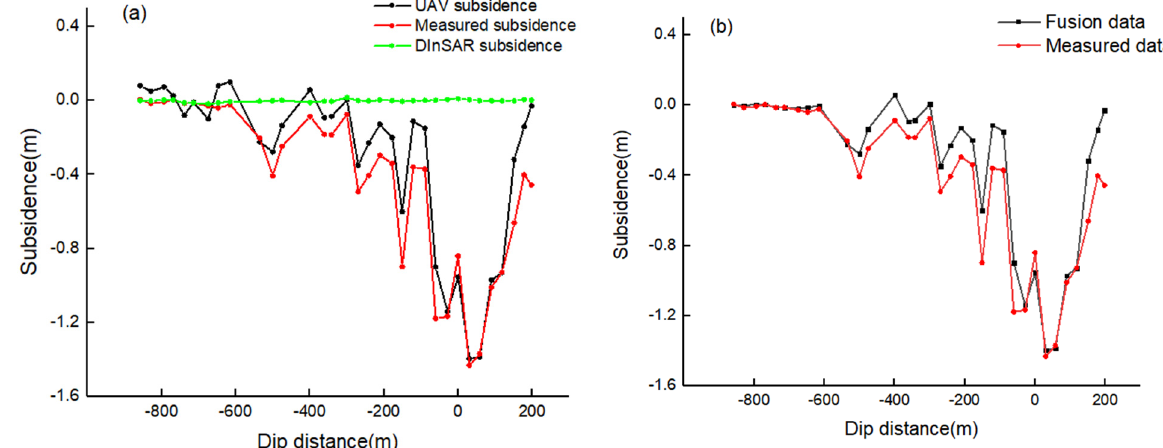
Figure 9. Results before fusion ( a ) and after fusion ( b ) along line A.